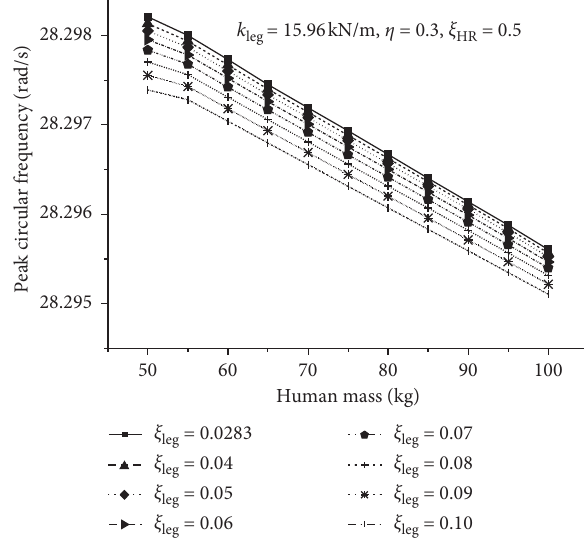
Figure 23: Peak frequency under leg stiffness 15.96kN/m, η � 0 . 3, and ξ